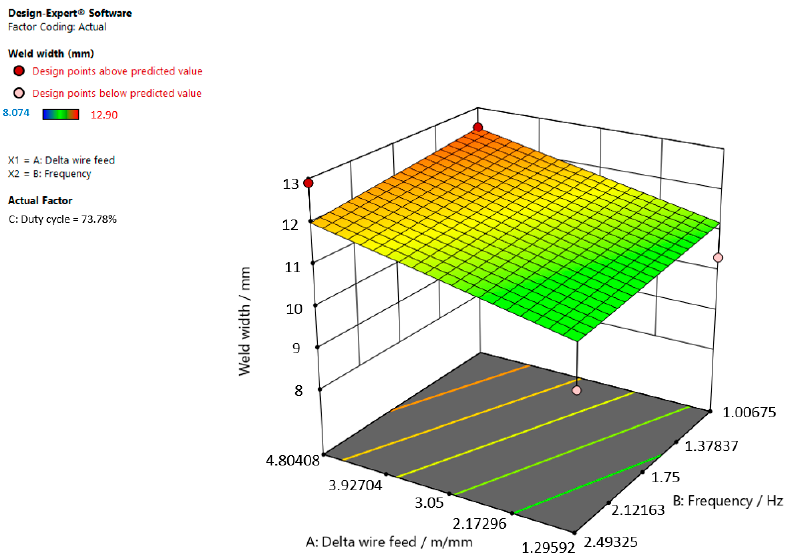
Figure 11. Response surface for the regression model of weld width at a duty cycle of 73.78%.